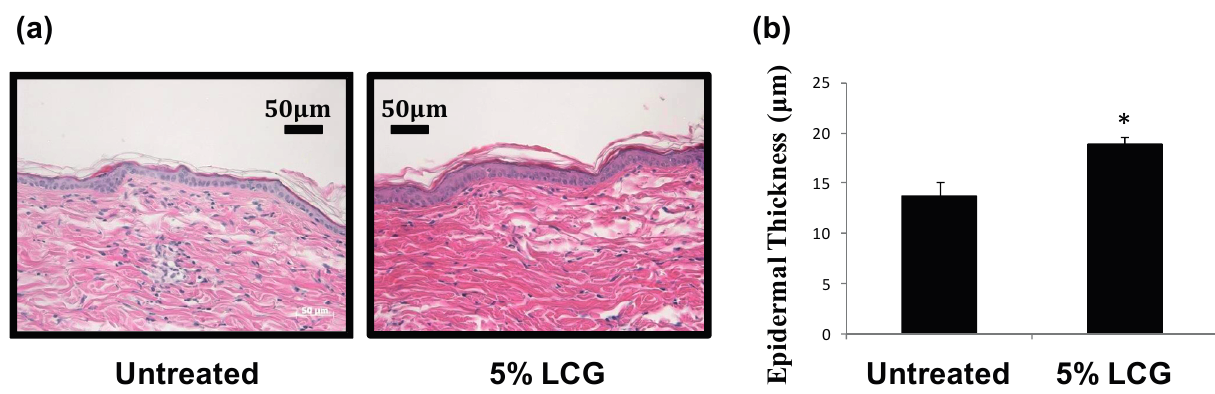
Figure 3. Five percent liquid crystal gel (LCG) induces statistically significant epidermal thickening when applied to mouse skin daily for four weeks. ( a ) Images of untreated and treated H&E-stained skin; ( b ) Epidermal thickness of untreated versus treated skin ( n = 3, * p <